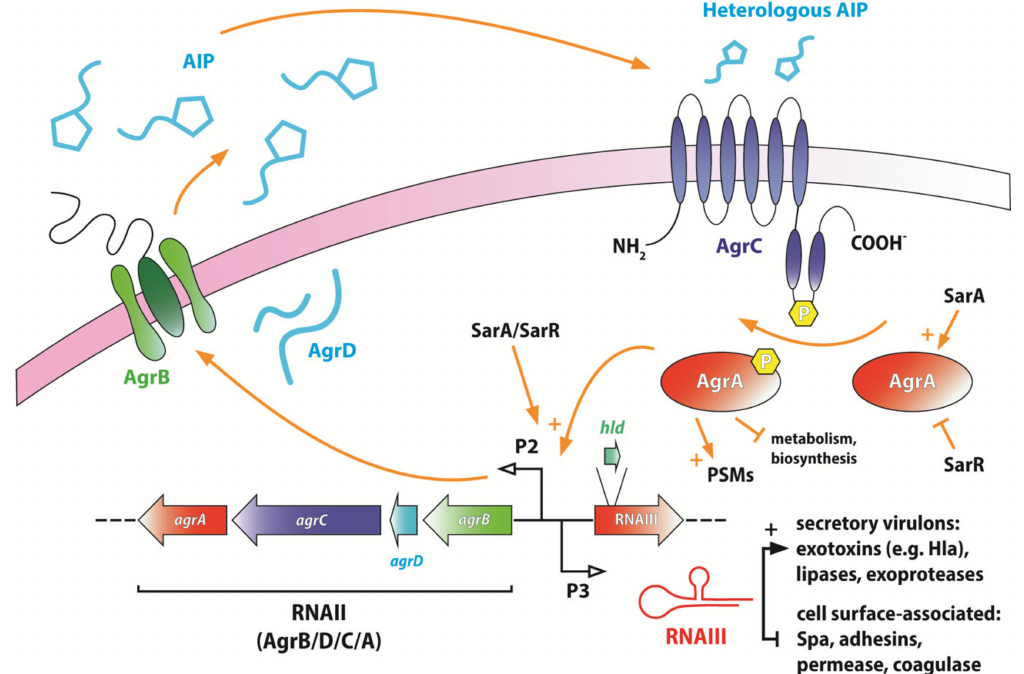
Figure 2. Schematics of the agr regulon in S. aureus and its relationship with key determinants of virulence and cell maintenance. AIP: autoinducing peptide; PSMs: phenol-soluble modulins. Figure modified from